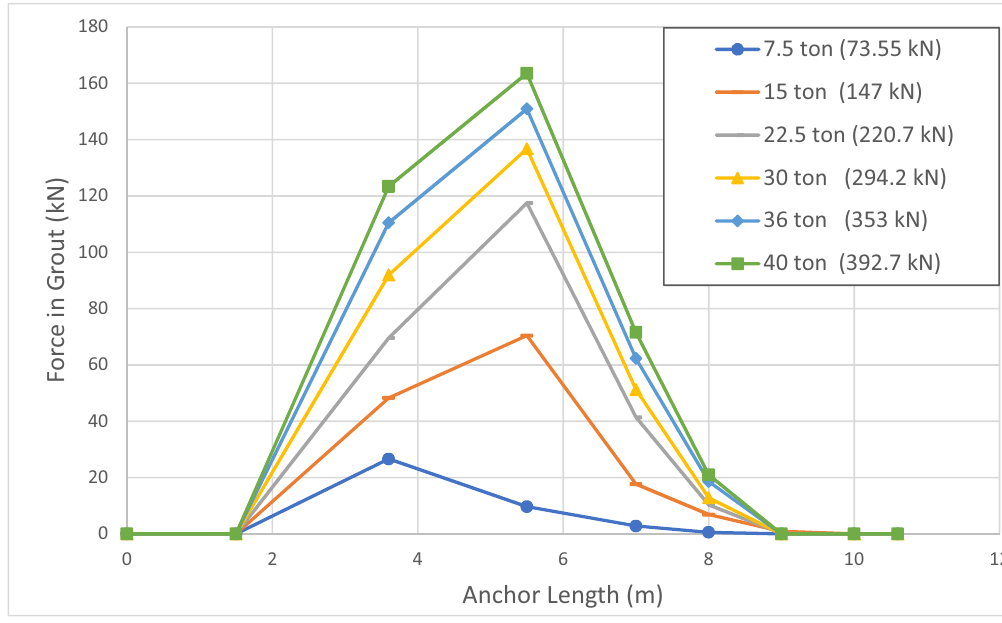
Figure 21: Forces along the grouted body of anchor 1, starting from the ground